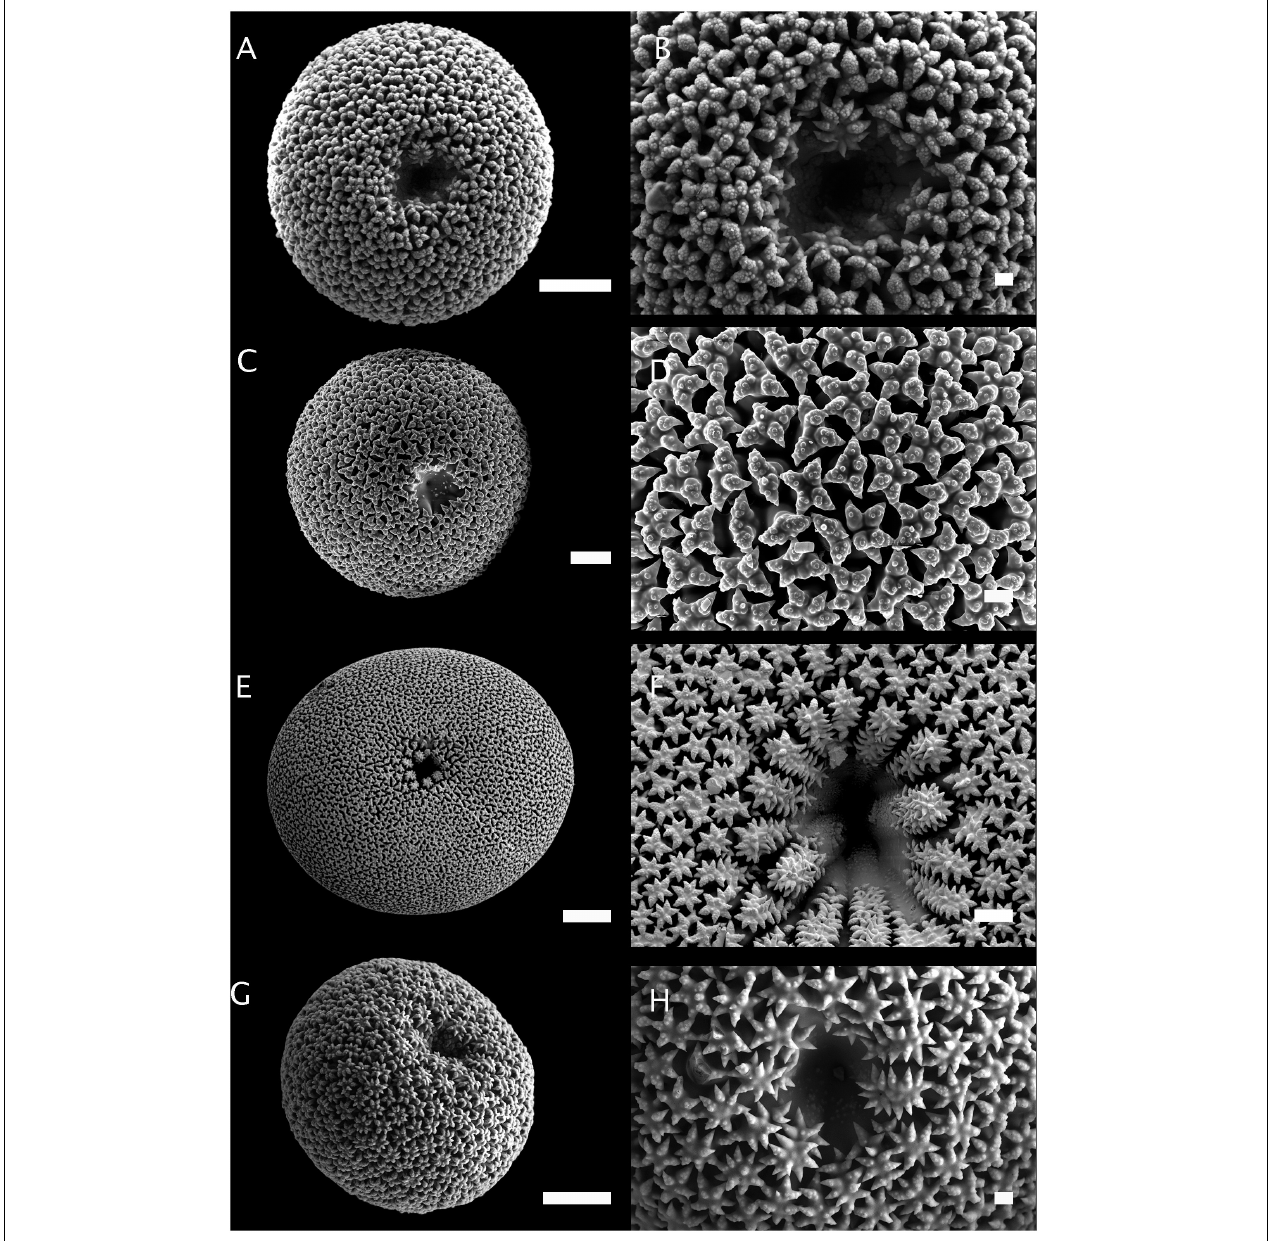
FIGURE 3 | Morphology of sterrasters with warty rosettes. (A,B) Sterraster of Geodia barretti (Norway, ZMBN 77922). Scale A: 20 µ m. Scale B. 2 µ m. (C,D) Sterraster of Geodia papyracea (holotype, YPM 5045). Scale C: 10 µ m. Scale D. 2 µ m. (E,F) Sterraster of Geodia macandrewii (Norway, ZMBN 89717). Scale E: